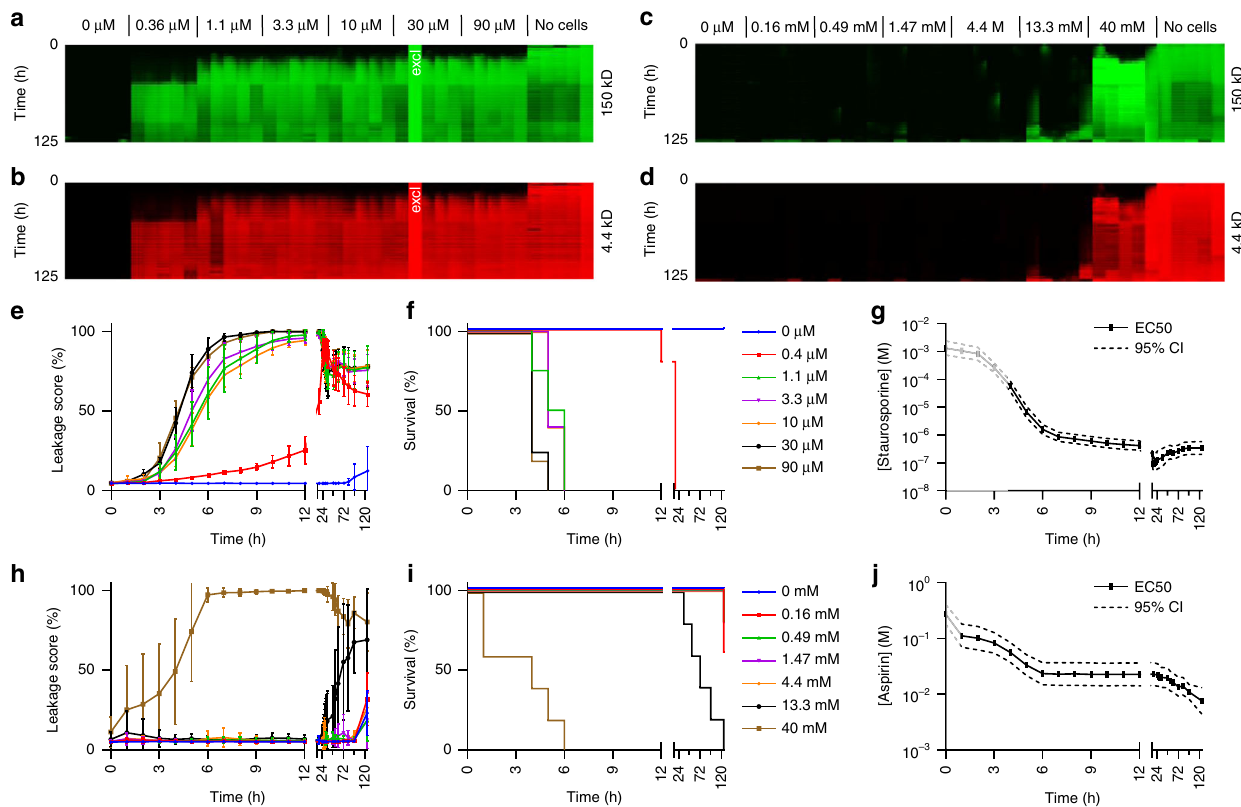
Fig. 4 Drug-induced loss of barrier integrity is observed over time in a concentration-dependent manner. Results shown for staurosporine ( a , b , e – g ) and aspirin ( c , d , h – j ). a – d Array of fl uorescence micrographs of the gel region showing distribution of the 150 kDa FITC-Dextran ( a , c ), and 4.4 kDa TRITC- Dextran ( b , d ) over time and for various compound concentrations; the loss of barrier integrity results in an increased fl uorescent signal. Measurements are taken at 1-h intervals up to 12 h, at 16 h, from 24 to 36 h at 1 h interval, and at 48, 53, 60, 72, 82, 96, and 125 h. In between each interval, the OrganoPlate was placed back into the incubator on the interval rocker platform to maintain the perfusion fl ow. Five technical replicates of each concentration of a compound were measured on a single plate. One well was excluded from further data analysis, because of a pipetting error (marked with “ excl ” in white ). e , h The progression of the loss of barrier function over time is plotted as the ratio between fl uorescent signal in apical and basal regions